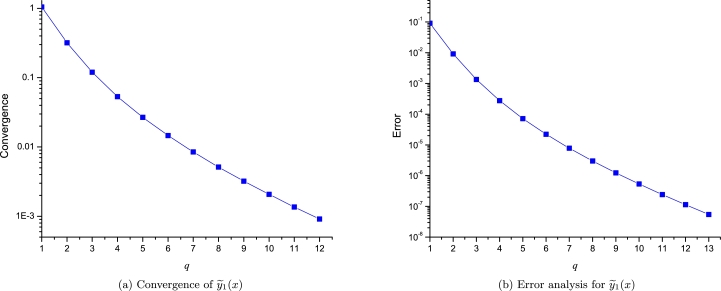
Convergence and error for y˜1(x) of T-F equation.